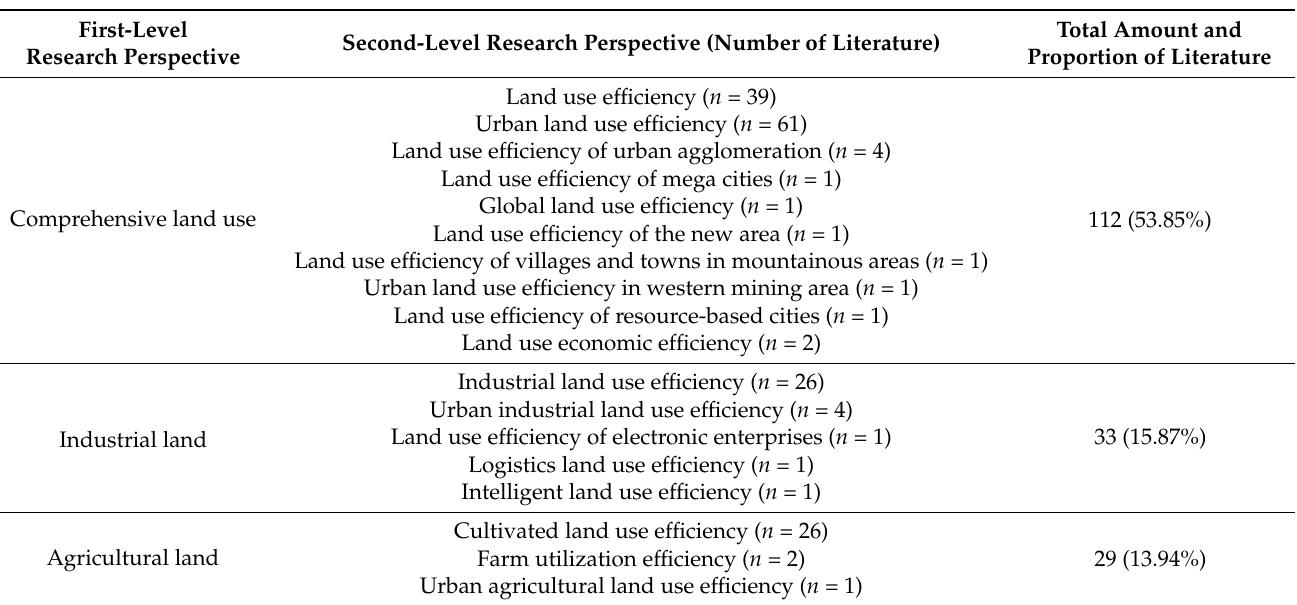
Table 2. Classification of research